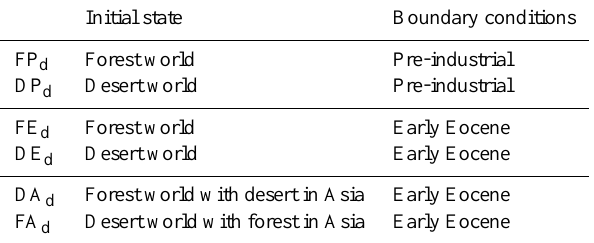
Table 3. Simulations included in the